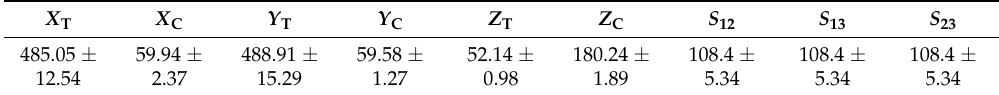
Table 3. Elastic parameters obtained in the mechanical test. Table 4. Strength parameters obtained in the mechanical test (MPa). Table 4. Strength parameters obtained in the mechanical test (MPa).